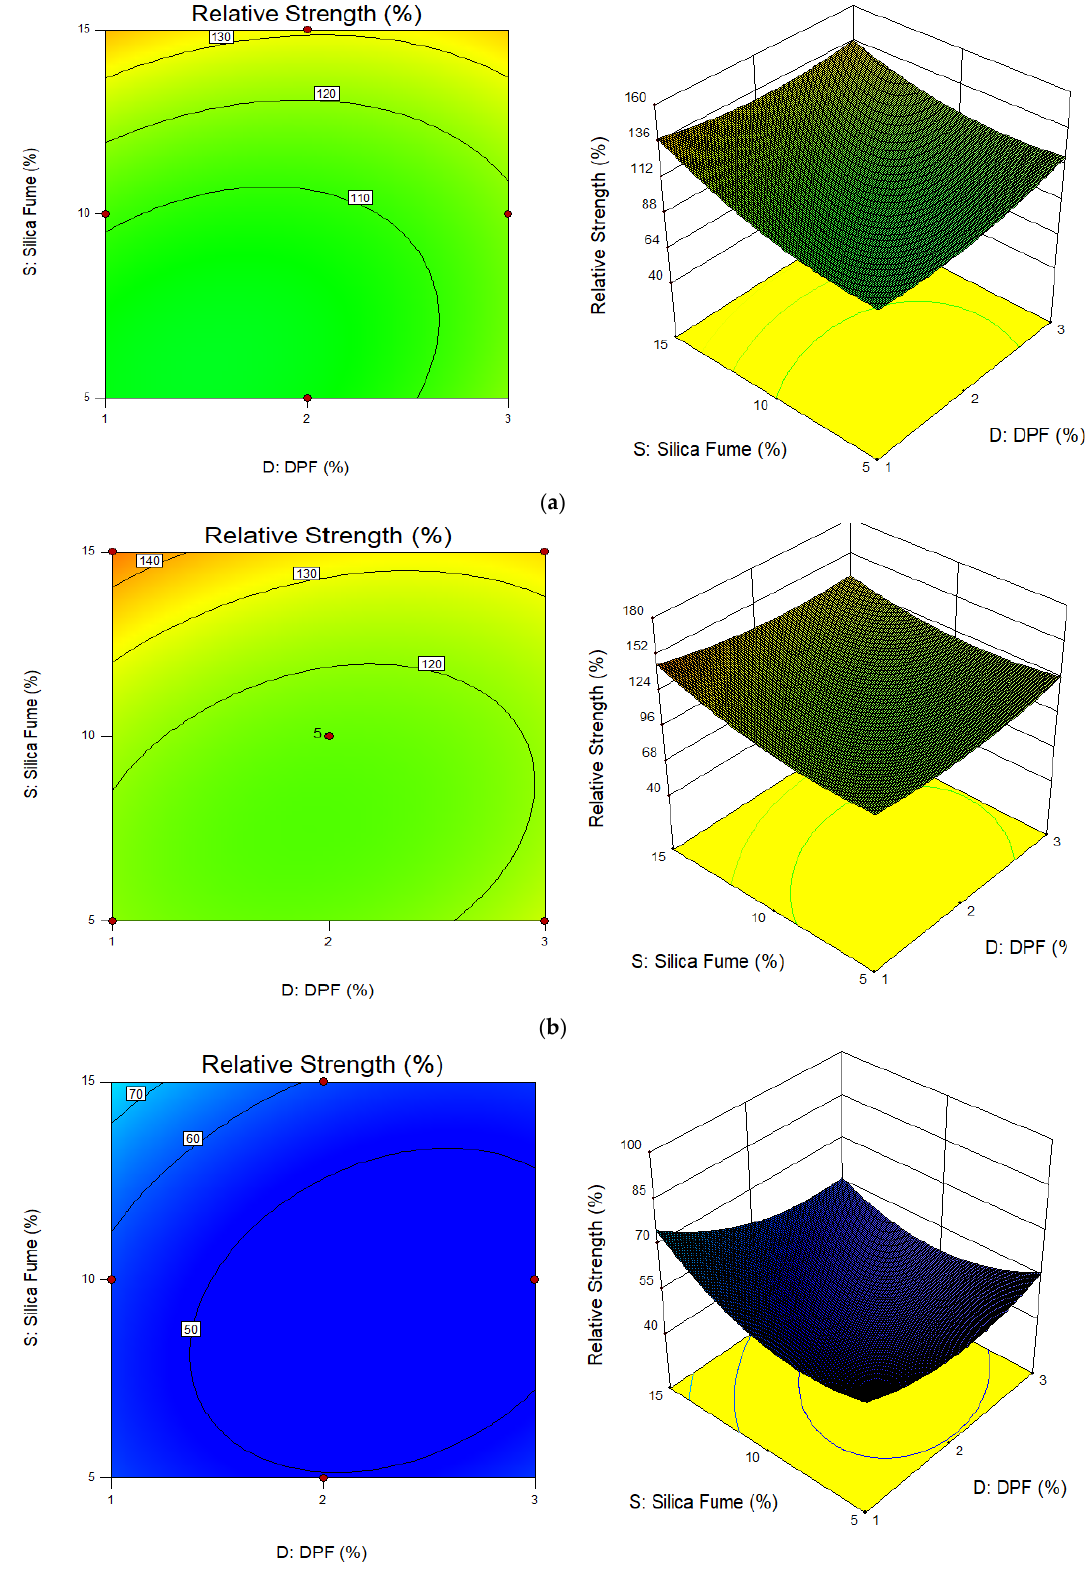
Figure 7. 2D contour and 3D response surface plots for compressive strength. ( a ) Temperature 200 °C; ( b ) temperature 400 °C; ( c ) temperature 600 °C.